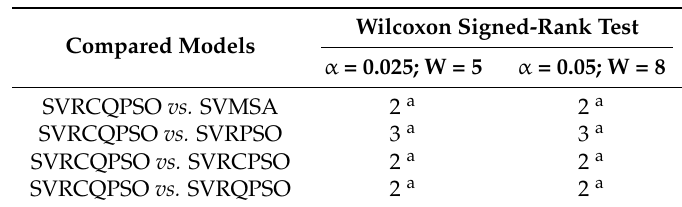
Figure 2. Actual values and forecasting values of SVRCQPSO, SVRQPSO, and other models (example two). Table 5. Wilcoxon signed-rank test (example two).